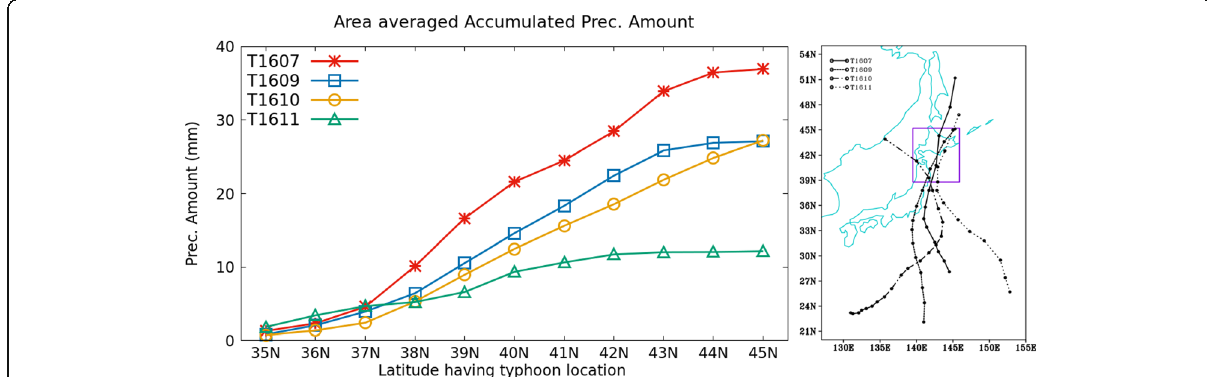
Fig. 7 Area-averaged precipitation amount (accumulated) during the passage of each typhoon through different latitudes. The right side figure shows the typhoon tracks from best-track data. The area corresponds to the land over northern Japan (highlighted as purple colour box in right side figure)